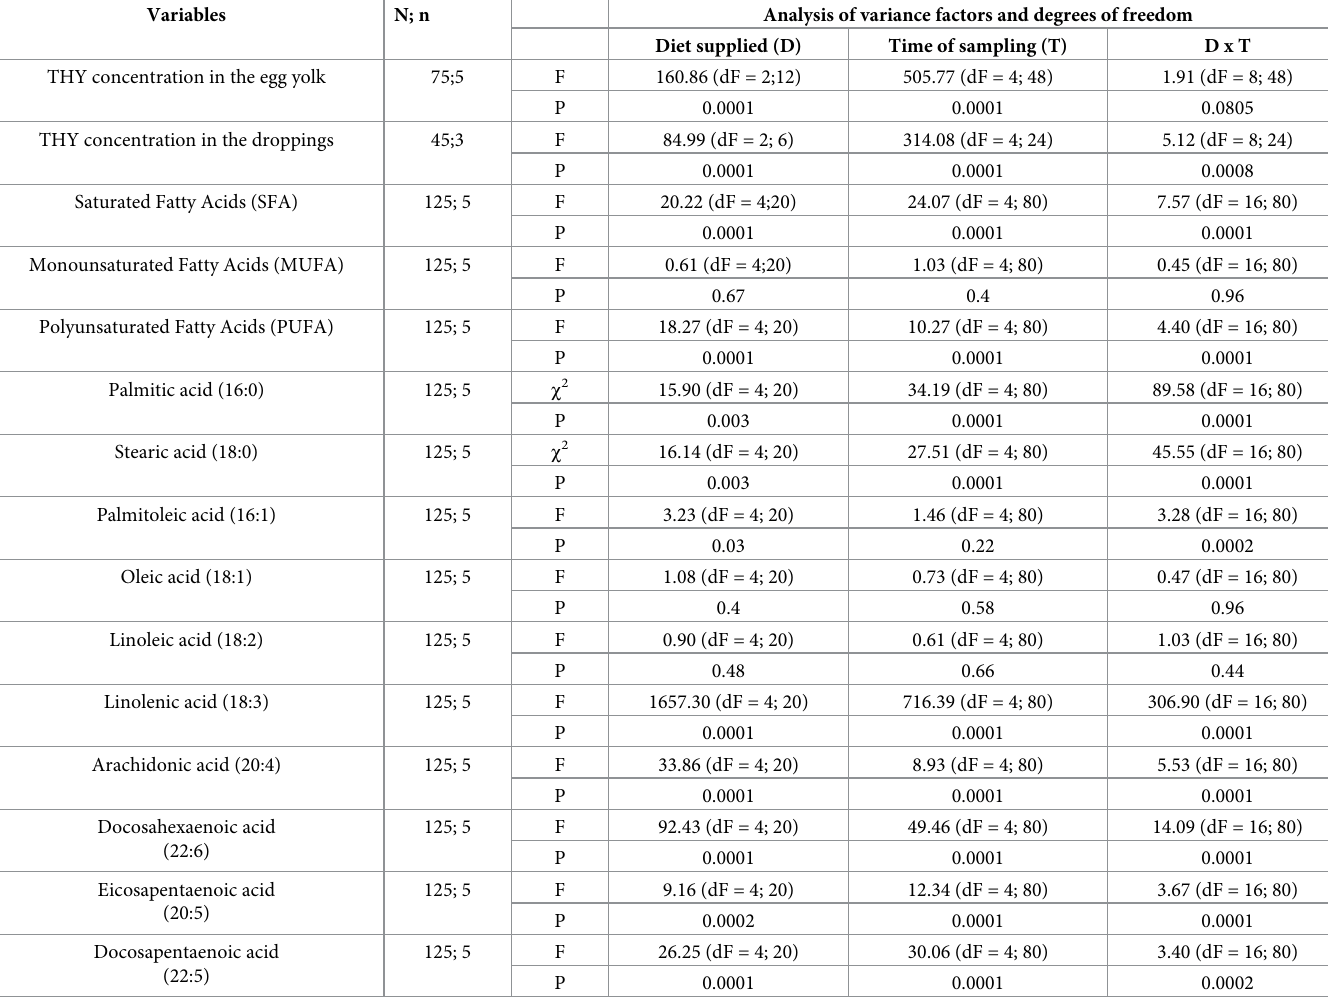
Table 1. Statistical information corresponding to the effects of the diet supplied, time of sampling and their interaction on thymol (THY) concentration in quail egg yolk and droppings and concentration of egg yolk total fatty acids.